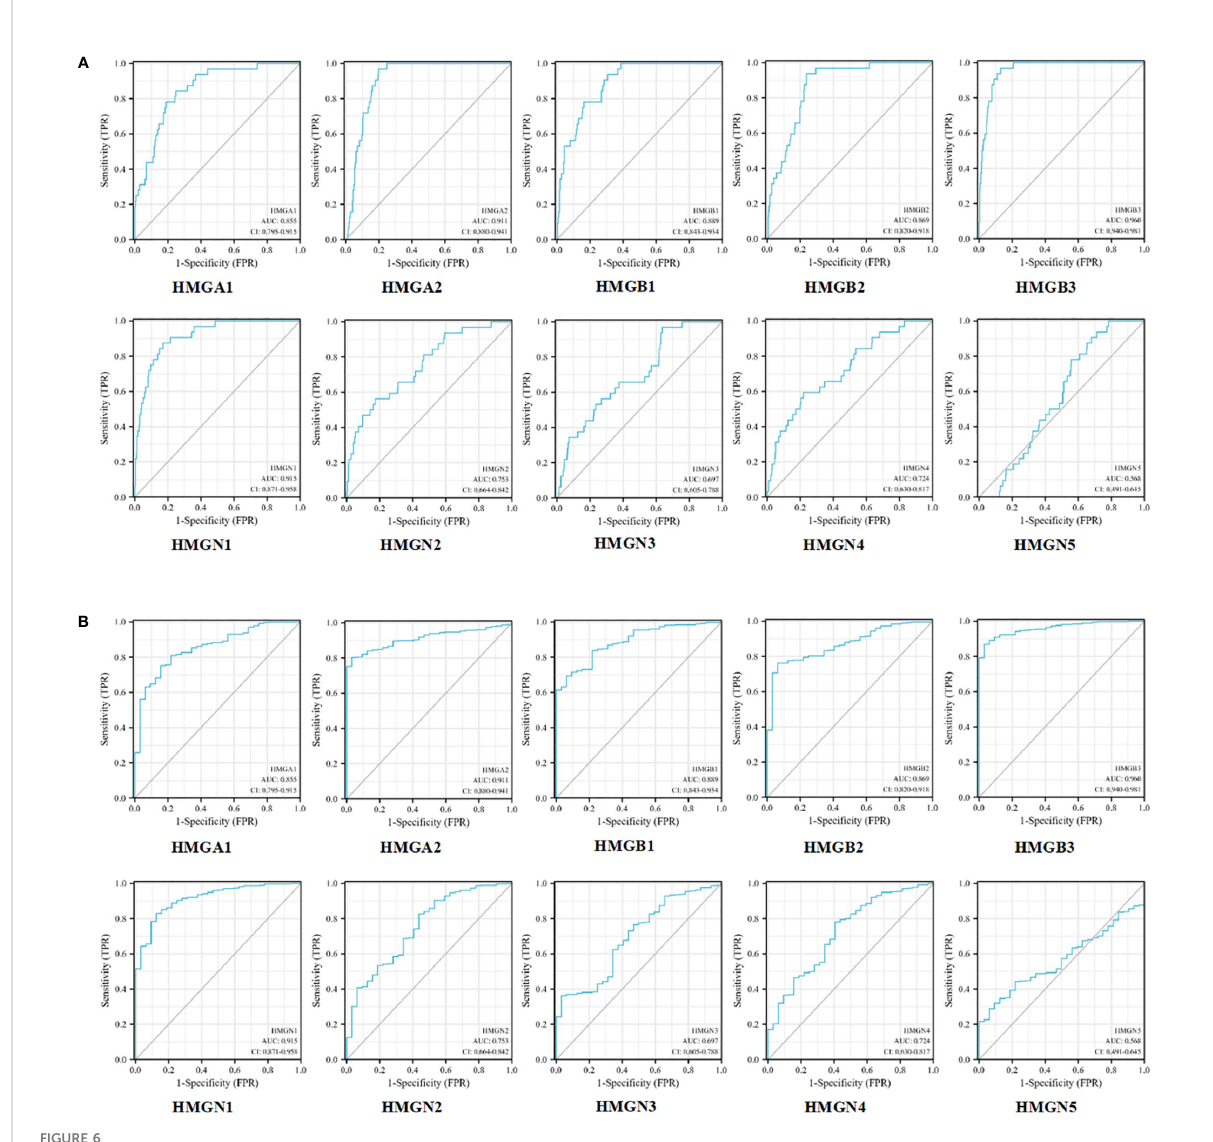
FIGURE 6 ROC curves for HMGs without (A) or with clinical staging (B) in